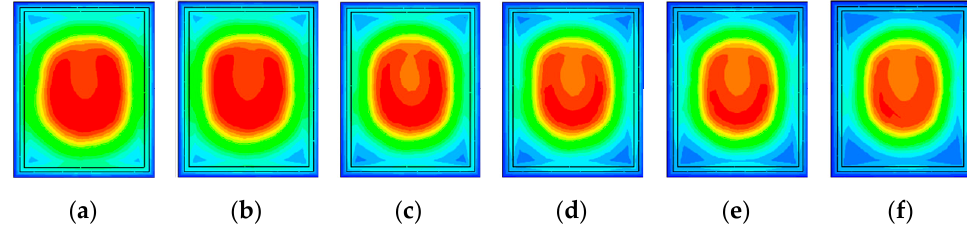
Figure 6. Temperature field of the burner exit (XY cross section) under different extension distances (K). ( a ) 0 mm, ( b ) 100 mm, ( c ) 200 mm, ( d ) 300 mm, ( e ) 400 mm, ( f ) 500 mm.